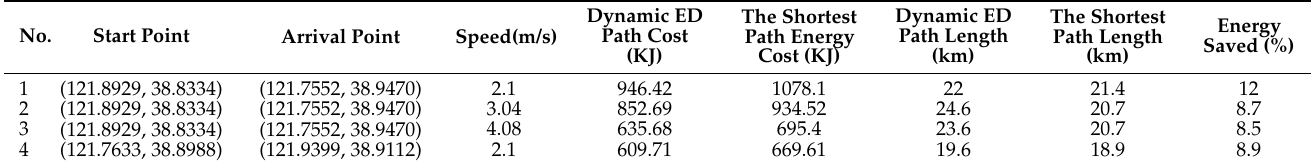
Table 10. Comparison of hourly dynamic energy-efficient path considers the distance and the shortest